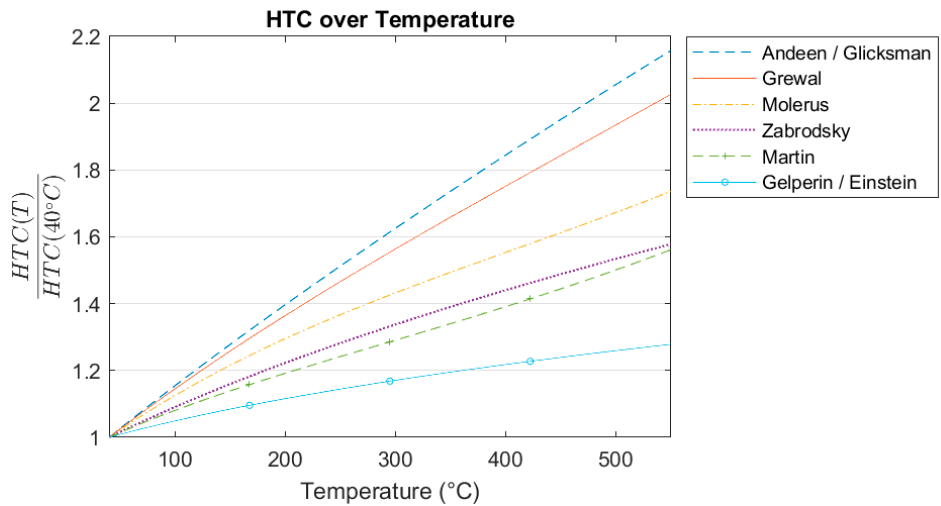
Figure 25. Comparison of HTC correlations depending on temperature, relative to 40 °C. The “packet model” by Mickley and Fairbanks [6] and the correlation by Bansal [3] show almost identical results to the correlation by Andeen and Glicksman. Using the correlation by Zabrodsky, since it represents a good average between the different correlations, the HTC at 400 °C is expected to be 1.44 times the one at 40 ° C.